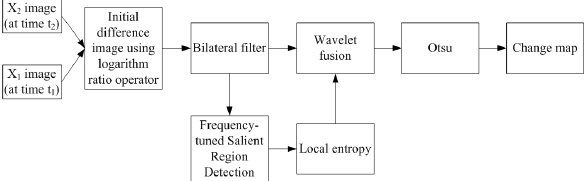
Figure 1: Framework of the proposed